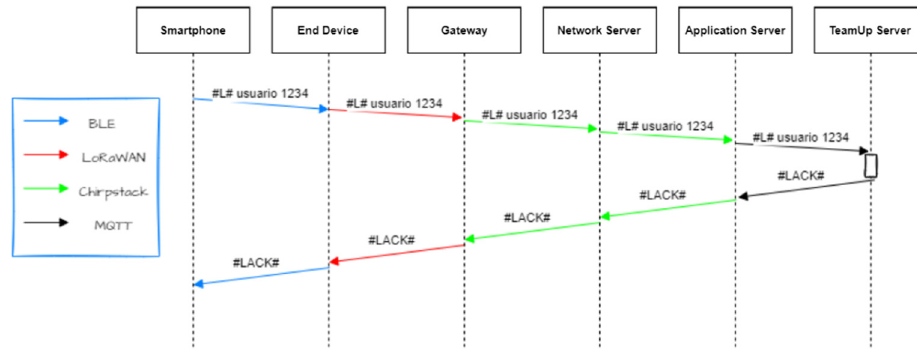
Figure 8. Sequence diagram of login messages for the TeamUp server.